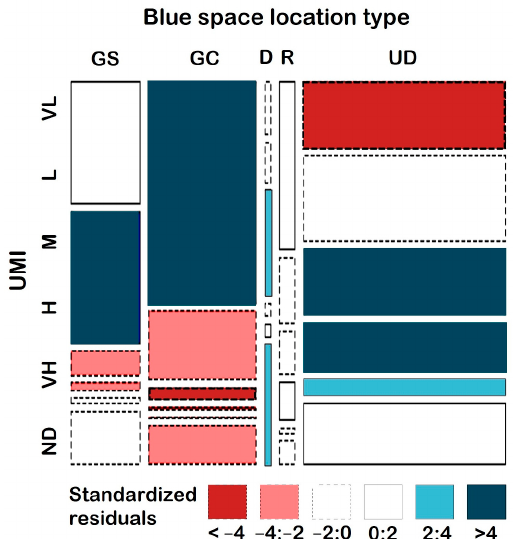
Figure 9. Mosaic plot for the association between IMU and the type of space where blue spaces are located. UMI: VL—Very low, L—Low, M—Medium, H—High, VH—Very high, ND—No data; lo-